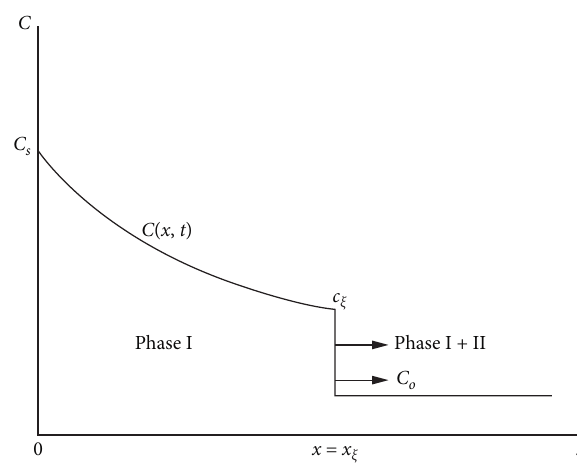
Figure 1: Coordinate for single-phase solid-state